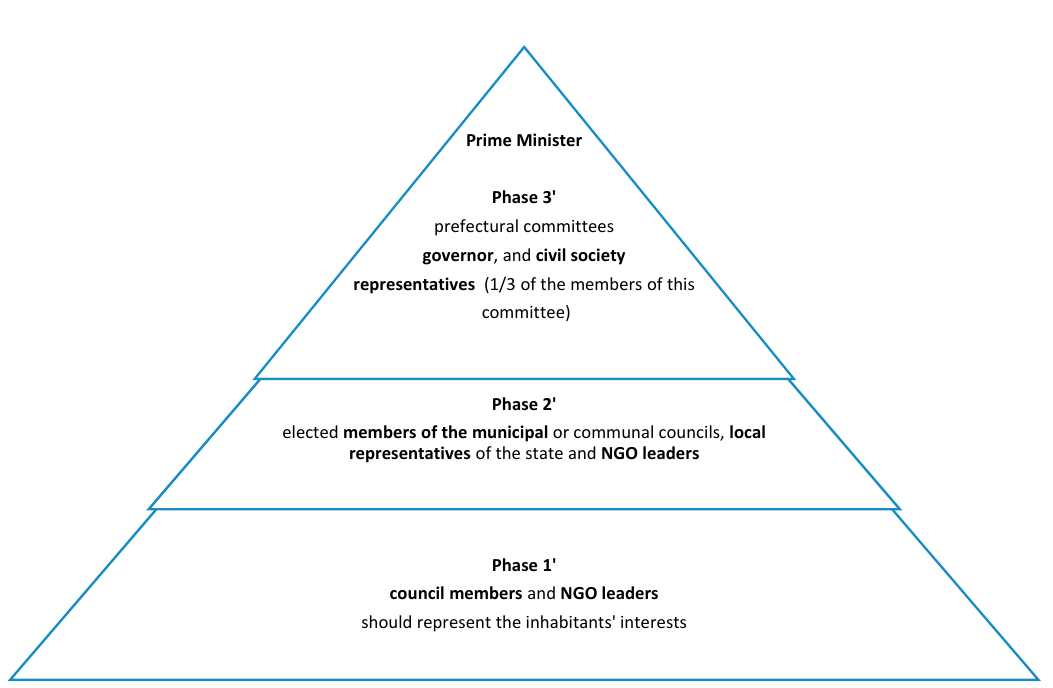
Figure 3. INDH development phases of the project implementation processes.